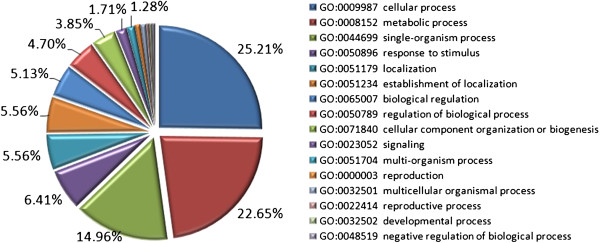
Functional classification of GO terms of 515 differentially expressed genes. In biological process, CateGOrizer grouped GO terms into 16 categories. The data for GO categories that represented less than 1% of the differentially-expressed genes are not shown. The most prevalent GO slim categories are cellular process (25.21%), metabolic process (22.65%) and single-organism process (14.96%), suggesting a high degree of basic metabolic activity in the regulation of nuclear genes in photosynthesis.